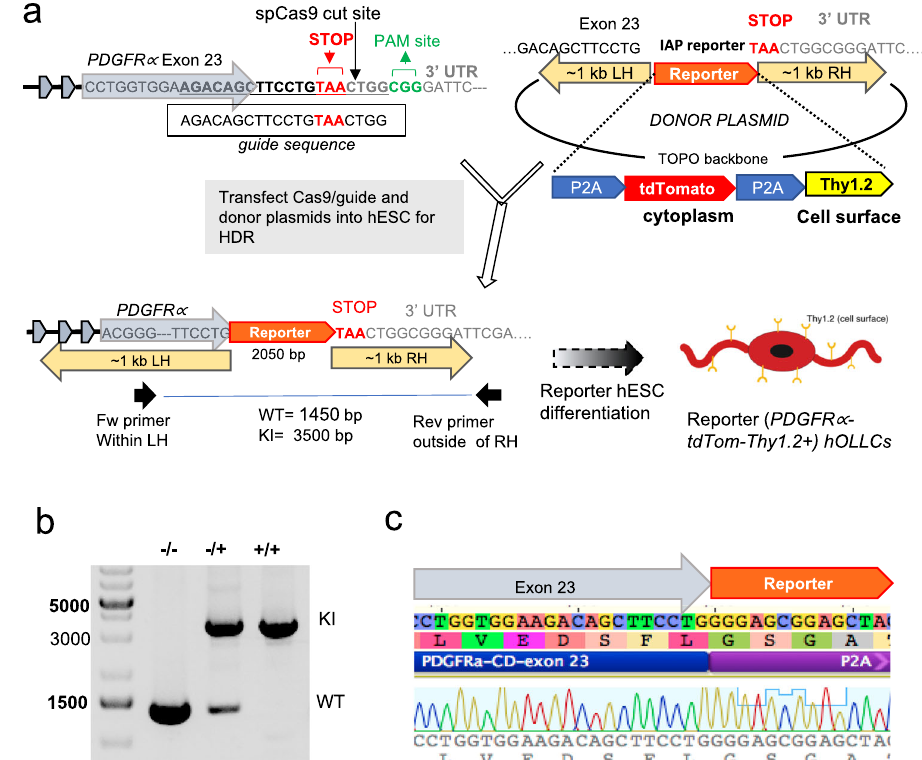
Fig. 1 Generation of PDGFR α reporter ES cell line. a Schematic diagram of IAP reporter knock-in into the PDGFR α locus using CRISPR – Cas9 genome editing. A plasmid containing spCas9 sequence and a guide sequence targeting the stop codon of the PDGFR α gene, and a separate “ donor ” plasmid containing reporter sequence fl anked by 1 kb homology arms were transfected into H9 ES cells. Following single-cell passaging, PCR-based genotyping was performed on individual clones using a primer set that spans the reporter sequence (one primer at the homology arm and the other outside the homology arm). b A representative PCR gel image that differentiates between WT, heterozygous, and homozygous knock-in clones. A full scan of the gel is included in Supplementary Fig. S1a. The PCR-based genotyping was independently repeated fi ve times with a similar result. c Sanger sequencing of the knock-in band to con fi rm insertion of the reporter at the correct (Fig. 2b). Of note, the antibodies against mouse Thy1.2 used in the puri fi cation are species-speci fi c and do not react against